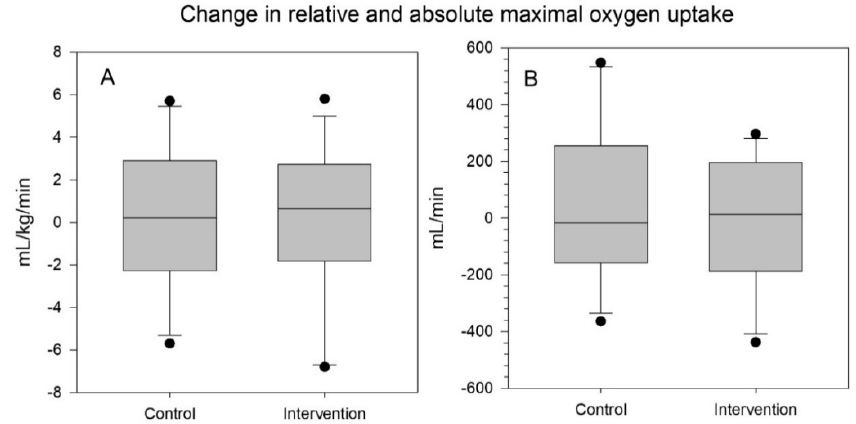
Figure 3. Change in maximal oxygen uptake, ( A ) relative to body mass, ( B ) absolute, in L / min.